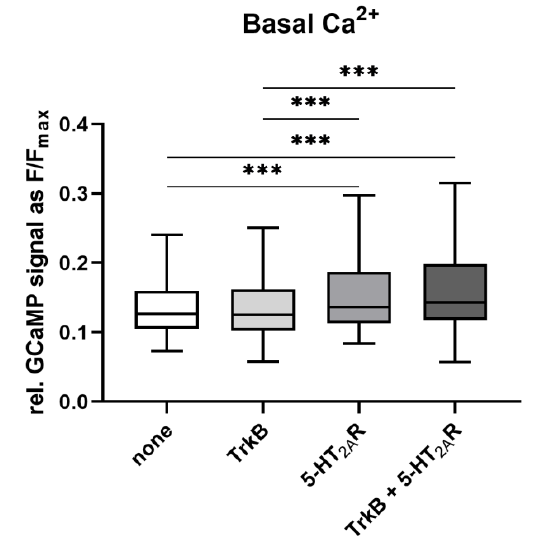
Figure 3. Heterodimerization does not affect basal Ca 2+ levels in N1E-115 cells. Neuroblastoma cells were transfected with Ca 2+ indicator GCaMP6f, either alone or together with 5-HT 2A -mTurquoise2, TrkB-YPet, or both. Basal Ca 2+ activity was calculated as F/F max . To saturate Ca 2+ levels, 10 μM ionomycin was applied after 6 min of recording. The saturated Ca 2+ signal was used as F max . Data are presented as means ± SEM (12 ≤ n ≤ 17). *** p < 0.001 (Kruskal–Wallis test with Dunn’s multiple-comparison post hoc test).